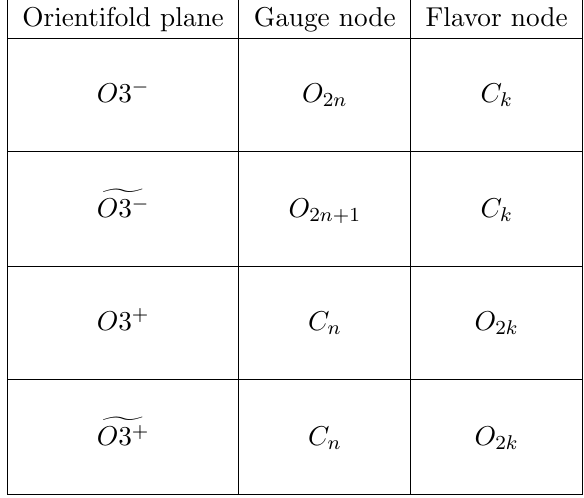
Table 2. Correspondence between nodes in the quiver and types of the orientifold plane in the Coulomb branch brane con(cid:12)guration. n is the number of D3-branes in the corresponding interval. k is the number of D5-branes in the interval (In the cases of O 3 + and g O 3 + k can be a half integer number). C r denotes the symplectic group Sp( r ) of rank r . O r denotes a (cid:13)avor group O ( r ). If k is a half integer in an interval with O 3 (cid:0) or g O 3 (cid:0) a phase transition can always be performed that moves half a D5-brane to an adjacent interval, without any brane creation/annihilation. These transitions need to be performed before the quiver can be read. We refer to this transition as the collapse of the Coulomb branch brane con(cid:12)guration. (The name collapse re(cid:13)ects the e(cid:11)ect of this transition on the partition de(cid:12)ned by the position of the half D5-branes along half NS5-brane intervals, for a detailed description of the collapse of a partition see section